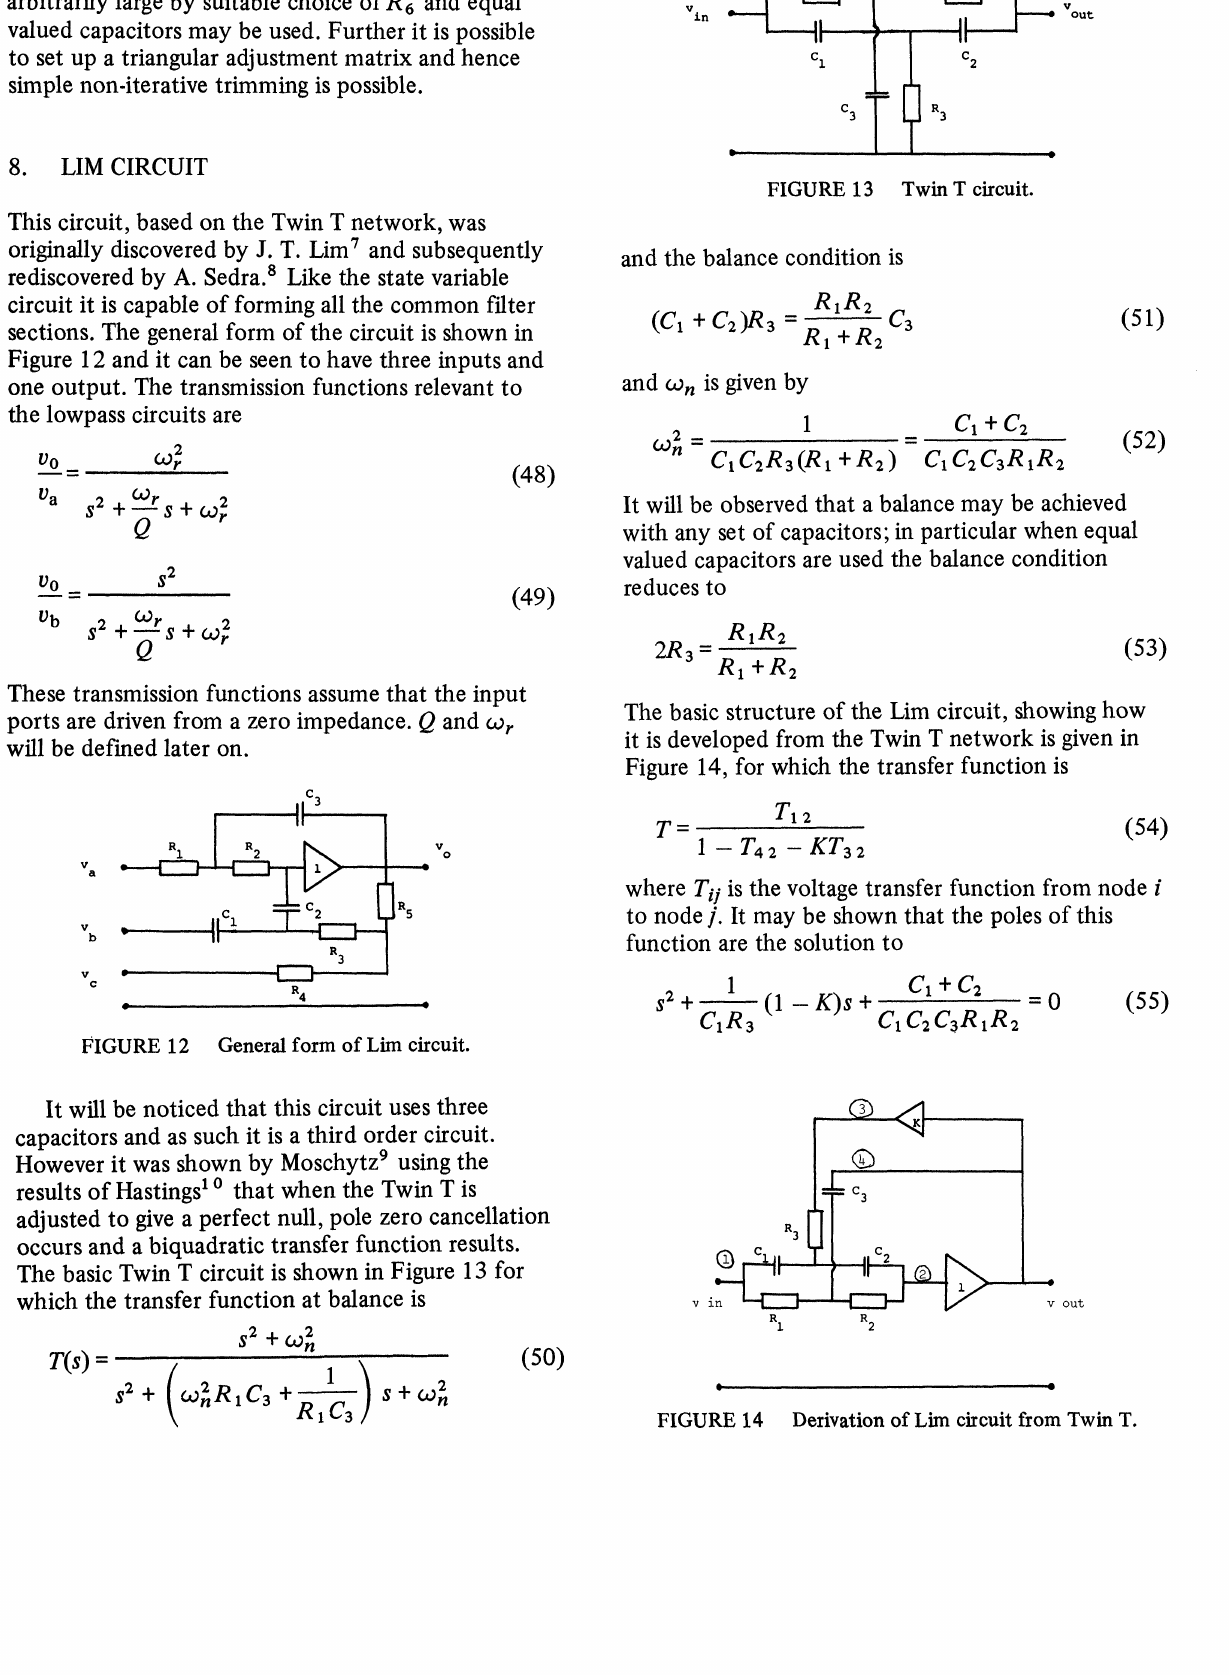
FIGURE 13 Twin T circuit.